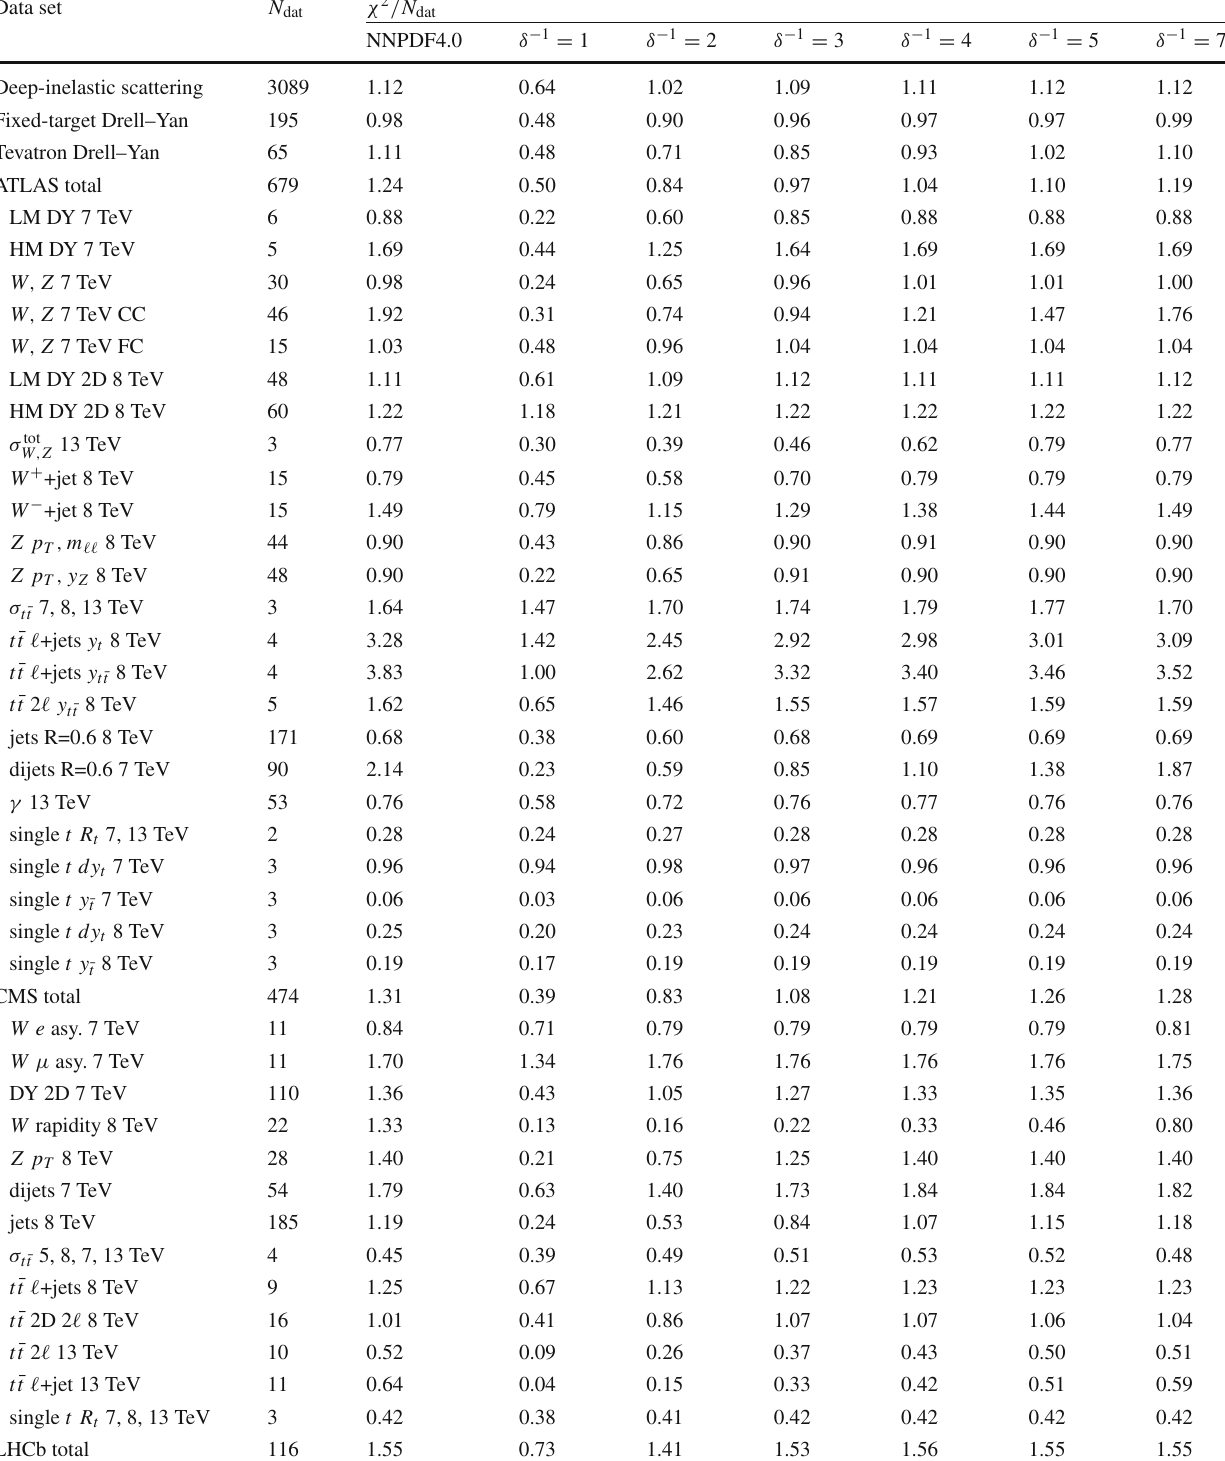
Table 2 The number of data points, N dat , and the χ 2 per data point, χ 2 / N dat , for the NNPDF4.0 NNLO baseline fit and for each of the fits performed with the regularisation procedure delineated in Sect. 3 for δ − 1 = 1 , 2 , 3 , 4 , 5 ,